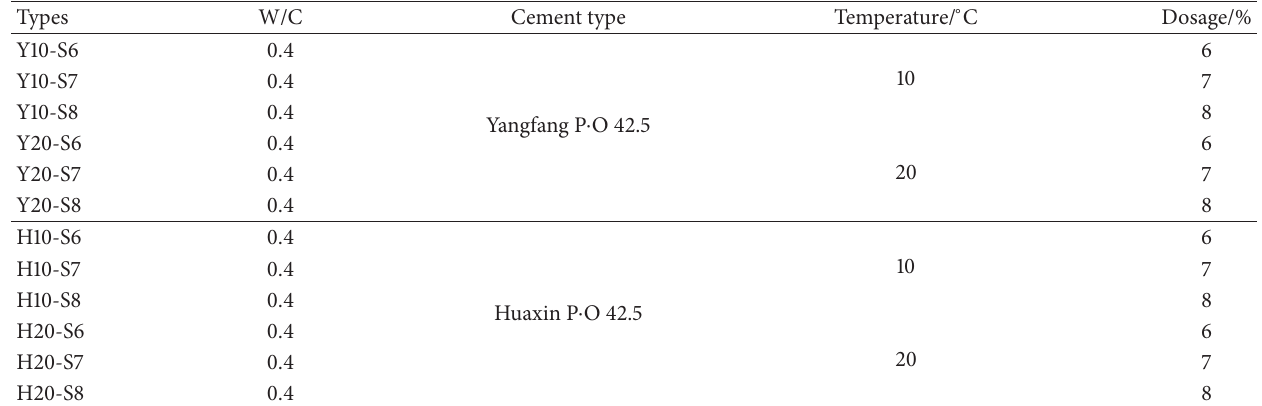
Table 3: Mix proportions of cement